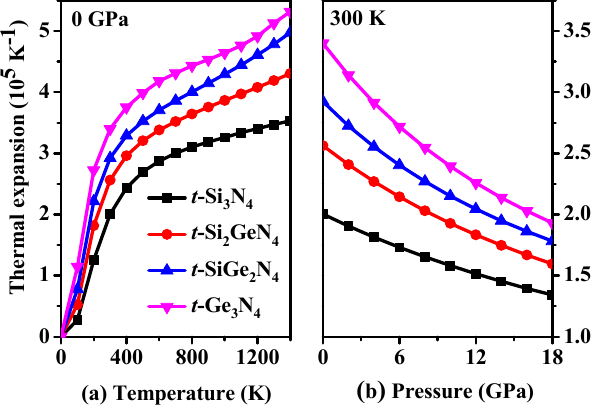
Figure 8. Temperature ( a ) and pressure ( b ) dependence of the thermal expansion coefficients for t -Si 3 N 4 , t -Si 2 GeN 4 , t -SiGe 2 N 4 , and t -Ge 3 N 4 .